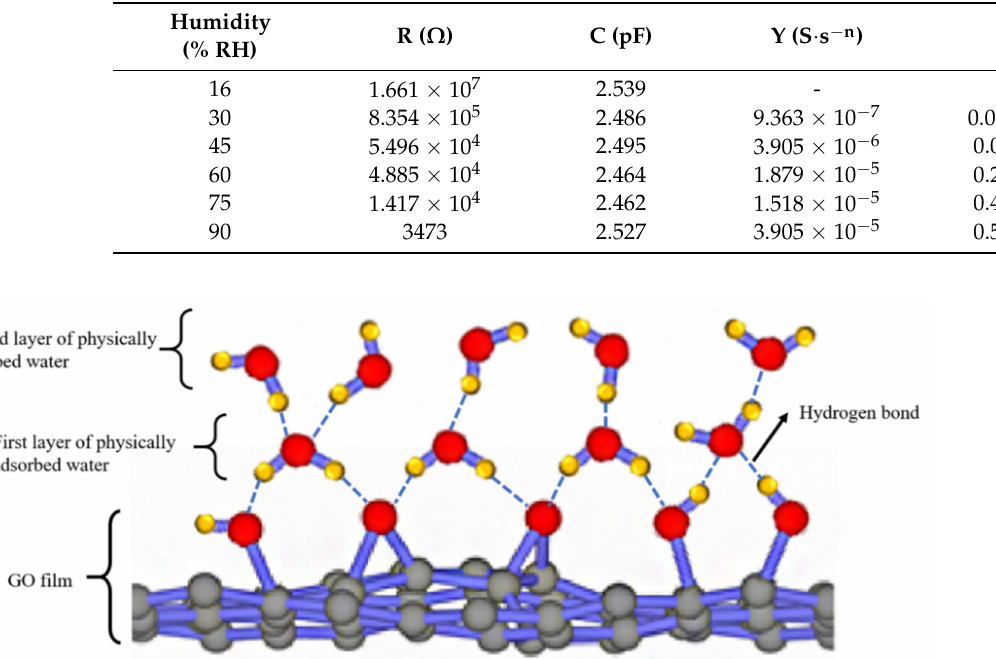
Figure 17. Schematic illustration for the humidity sensing mechanism of GO films. The first-layer water molecules are attached on GO through double hydrogen bonds. From the second layer, water molecules are adsorbed only through one hydrogen